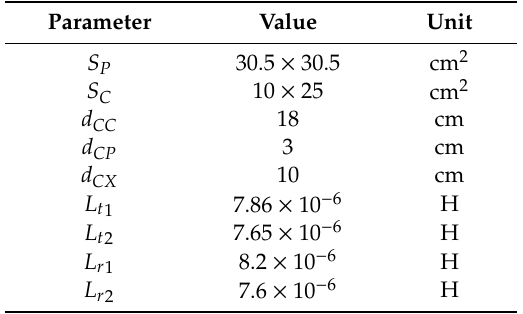
Table 6. Hardware parameters of the shielded-CPT system for the design